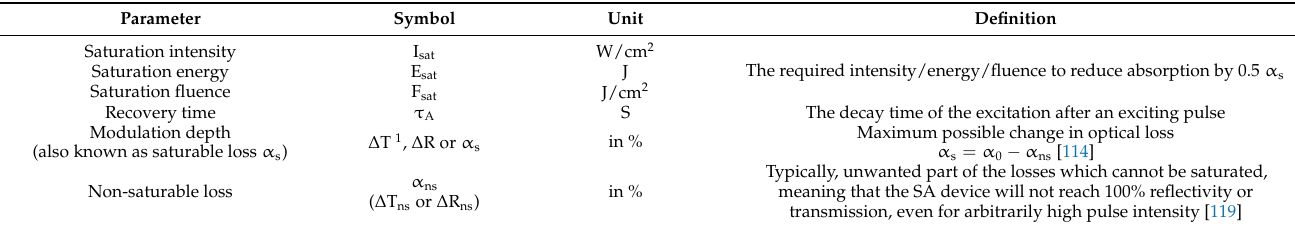
Table 1. SA parameters, their units and